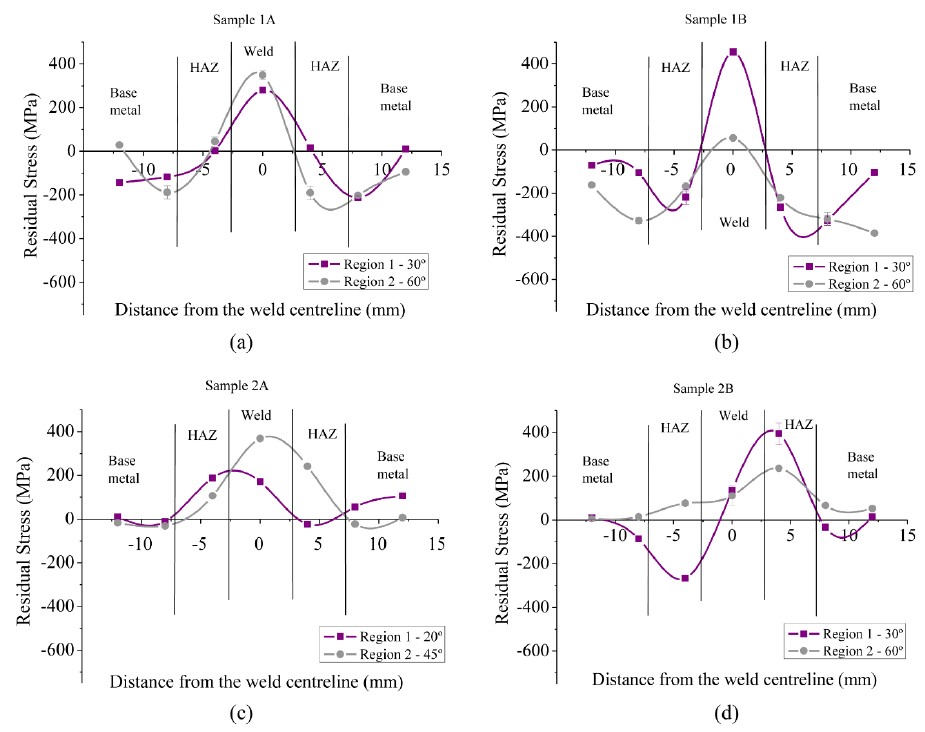
Figure 5. Residual stress located at root after welding on the samples: (a) 1A; (b) 1B; (c) 2A; (d) 2B.